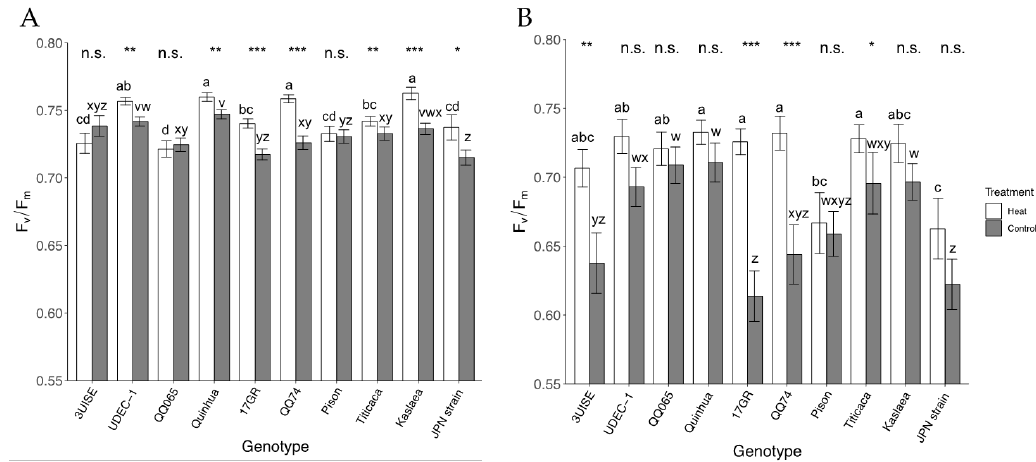
Figure 5. Maximum quantum yield of photosystem II (F v / F m ) measured at pre-dawn ( A ) and afternoon ( B ) of 10 quinoa genotypes exposed to a four-day heat treatment (45 ◦ C / 30 ◦ C) and control treatment (20 ◦ C / 14 ◦ C); day and night, respectively. Measurements were taken between 05:00 and 06:30 (pre-dawn) and between 14:00 and 15:30 (afternoon). Values are means ± SE ( n = 15–32). Mean comparisons are shown for within genotype (asterisks and n.s.) and within temperature treatment (Heat: a to d;